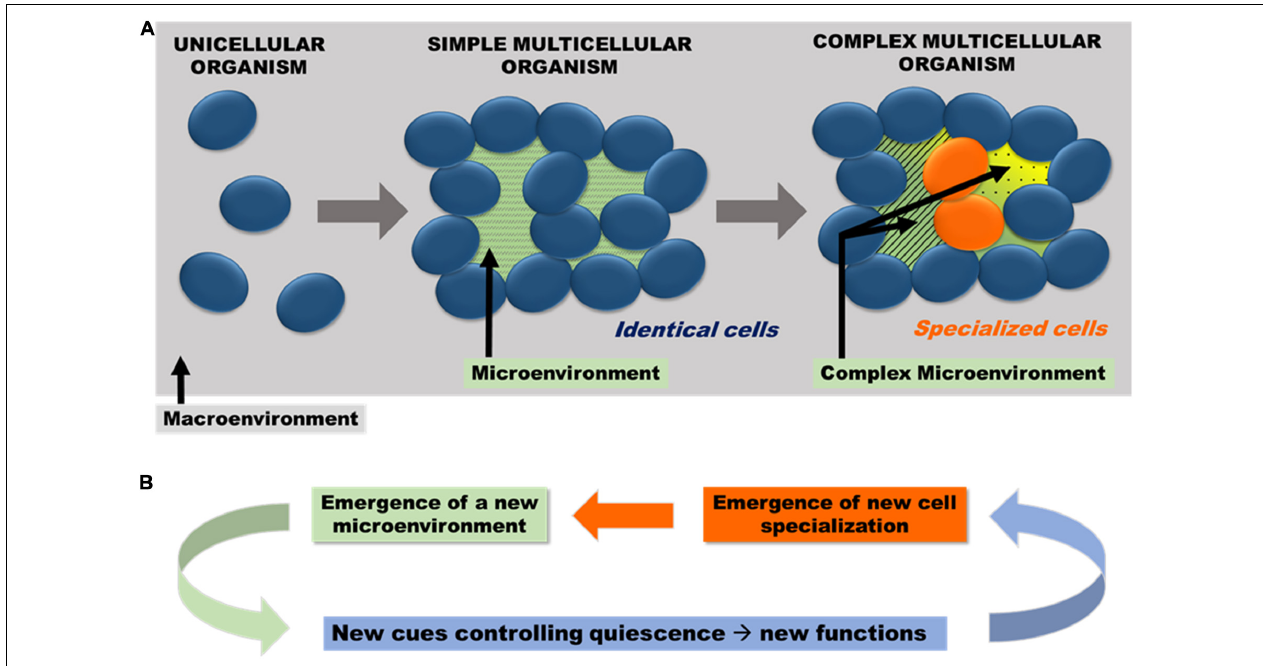
FIGURE 1 | (A) Emergence of microenvironment and cell specialization. By “simple multicellular organism,” we mean a multicellular entity composed of identical cells and by “complex multicellular organism,” an organism composed of non-identical cells i.e., cells with different cellular properties. As such, “complex multicellularity” emerged together with cell specialization. Multicellularity physically generates a microenvironment that isolates some cells from the direct contact with macroenvironment. Complex microenvironment (secreted metabolites, diffusive proteins, extracellular matrix, etc.) and the tissue architecture become key in controlling quiescence. Hence, multicellularity may have allowed quiescence to evolve away from nutritional signals. (B) Quiescence in a buffered microenvironment favors the emergence of cell specialization, which in turn generates a more complex microenvironment hence closing an auto-complexification loop.